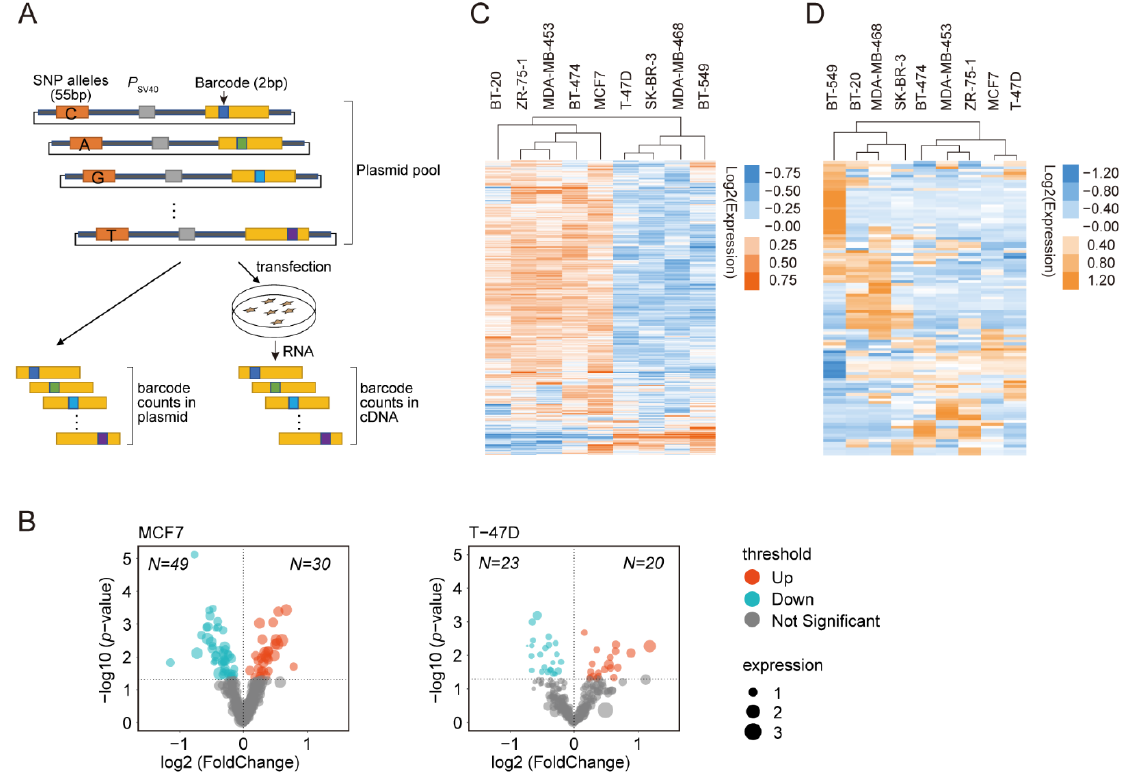
Figure 1. DiR ‐ seq analysis in breast cancer cells. ( A ) DiR ‐ seq workflow. The 55 bp genomic DNA regions carrying each allele at the center were inserted upstream of the SV40 promoter in the DiR ‐ Promoter vectors. The resulting DiR ‐ seq plasmid libraries were then transfected into breast cancer cells, and NGS libraries were then prepared from cDNA and template DNA. The expression level of each reporter tag was determined by counting the corresponding NGS read number in cDNA and then calibrated with the value from template DNA. ( B ) Volcano plots of DiR ‐ seq results for the MCF7 and T ‐ 47D cells. p values came from a two ‐ tailed Student’s t ‐ test of effect sizes of two alleles. Dashed horizontal lines indicate the p ‐ value < 0.05 cutoff. The regulatory SNPs exhibiting increased activity with the risk allele are shown in orange; those with decreased activity are shown in blue. Gray dots represent SNPs showing no significant difference between alleles. ( C ) Hierarchical cluster analysis of DiR ‐ seq report activity for nine breast cancer cell lines. Each row represents one SNP allele, and each column represents one cell line. As shown in the color bar, white represents no change, orange represents upregulation and blue represents downregulation of the reported activity. The expression levels of each allele are shown with row normalization using Z ‐ score. ( D ) Hierarchical cluster analysis of genome ‐ wide gene expression profiles of nine breast cancer cell lines. Genes were restricted to those showing significant variance across nine cell lines, resulting in the clustering of 109 genes. Each row represents a gene, and each column represents a cell line. As shown in the color bar, white represents no change, orange represents upregulation and blue represents downregulation of gene expression. The expression levels of each gene are shown with row normalization using Z ‐ score.